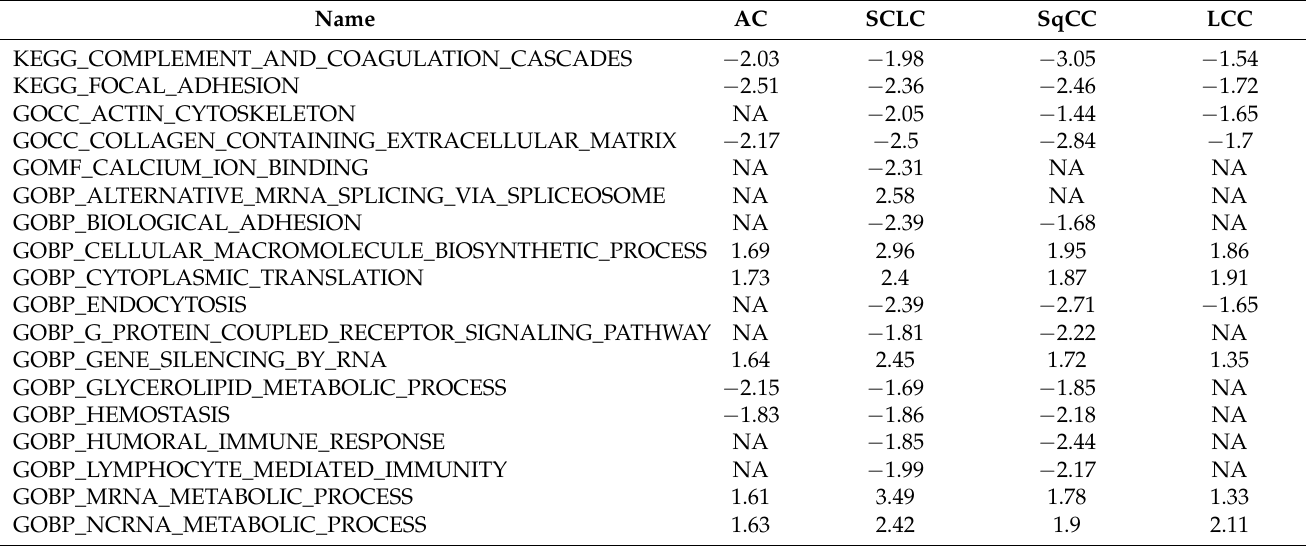
Table 4. Excerption of the dysregulated biological pathways along with Normalized Enrichment Scores